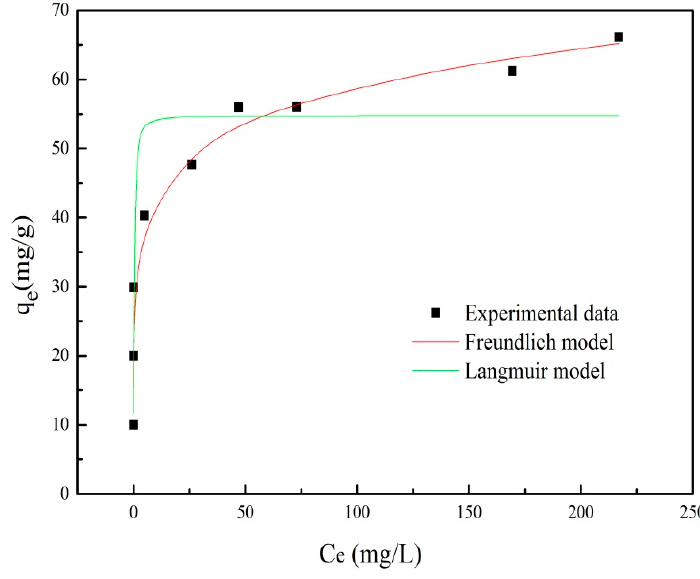
Figure 11. The adsorption isotherm of PRO onto ATP/Fe 3 O 4 /GO. Table 2. The adsorption isotherms parameters for PRO adsorption onto ATP/Fe 3 O 4 /GO. Langmuir Equation Freundlich Equation